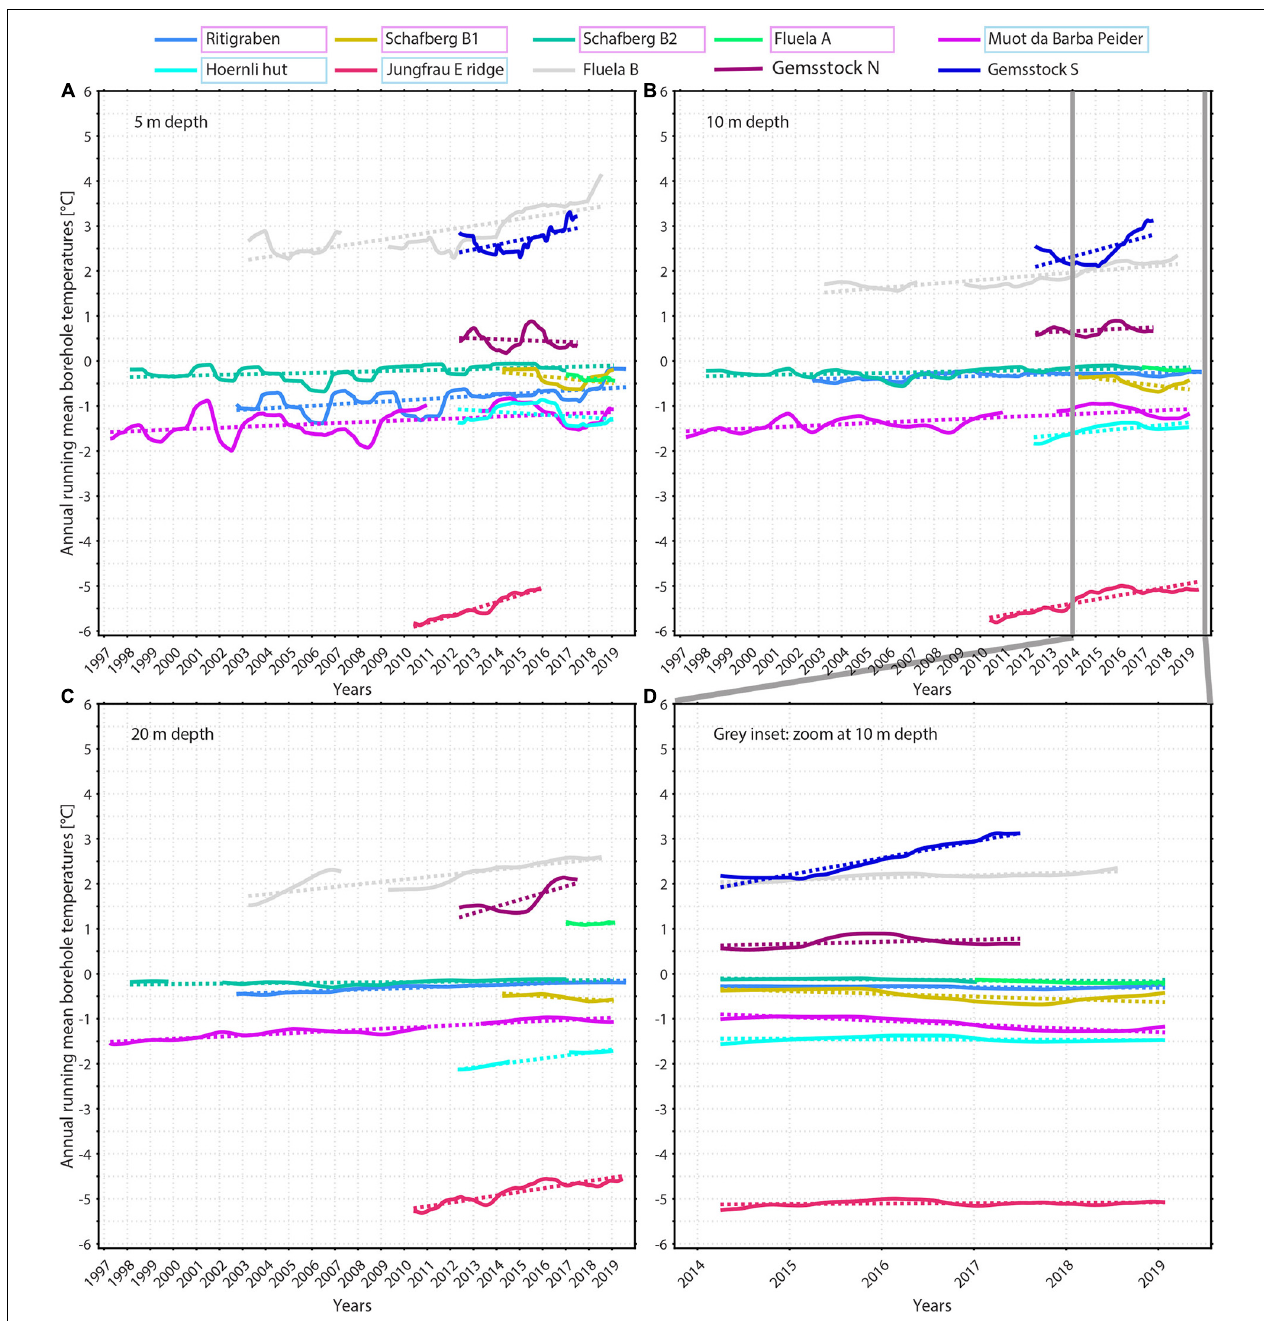
FIGURE 6 | Running 365-day means of ground temperatures (solid lines) measured in various high alpine SLF boreholes at approximately (A) 5 m, (B) 10 m, and (C) 20 m depth (see Table 1 for exact sensor depths). In addition, linear ground temperature trends (dotted lines) are calculated based on annual running mean ground temperatures, including those in non-permafrost locations. (D) Zoom into the grey inset in (B) at 10 m depth: here short-term ground temperature changes are additionally calculated for all boreholes for the same time period as of borehole Schafberg B1 (if applicable). The coloured frames indicate the ice content of the boreholes: pink for ice-rich, light blue for ice-poor, and no frame for permafrost-free locations.